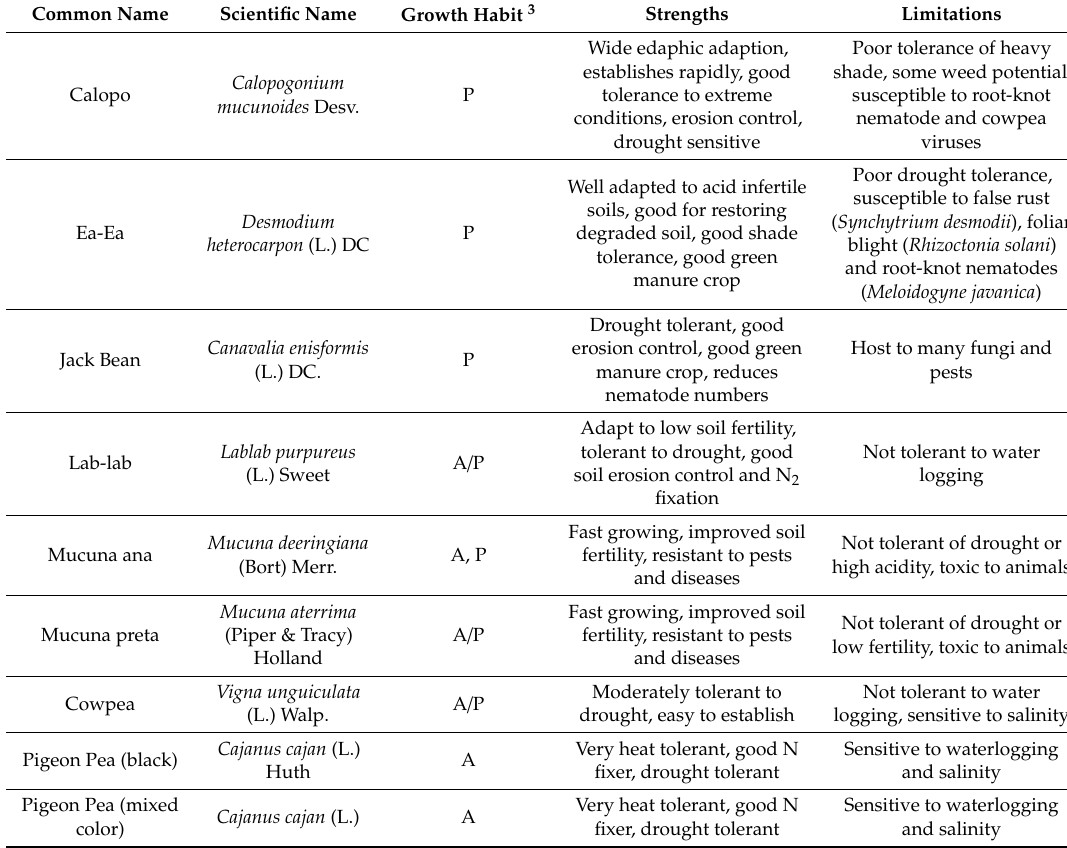
Table 1. Common and scientific names, growth habits, strengths and limitations of legume cover crop species used in this experiment 1,2